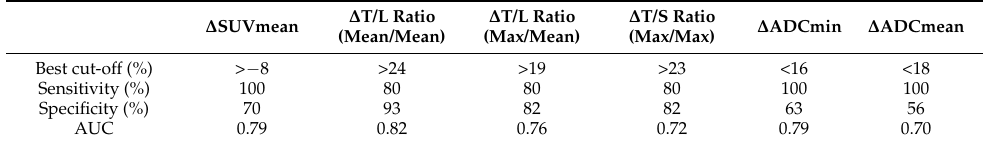
Table 5. ROC analysis of SUV and ADC for predicting HPFS < 6 months.